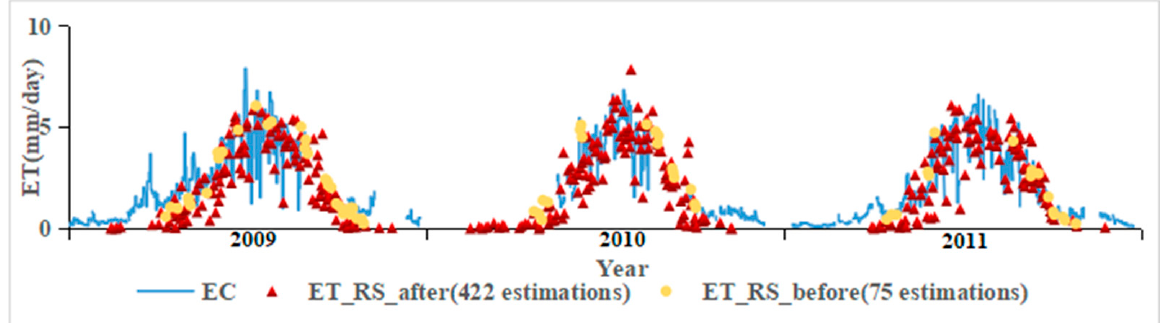
Figure 10. Comparisons of ET estimates from reconstructed LST derived Ts-VI model (ET_RS_after), original LST derived Ts-VI model (ET_RS_before), and measured ET, from 2009–2011. Triangles represent the original MODIS LST derived ET, where ET: evapotranspiration; RS: data derived from remote sensing; EC: data observed from eddy covariance; LST: land surface temperature.